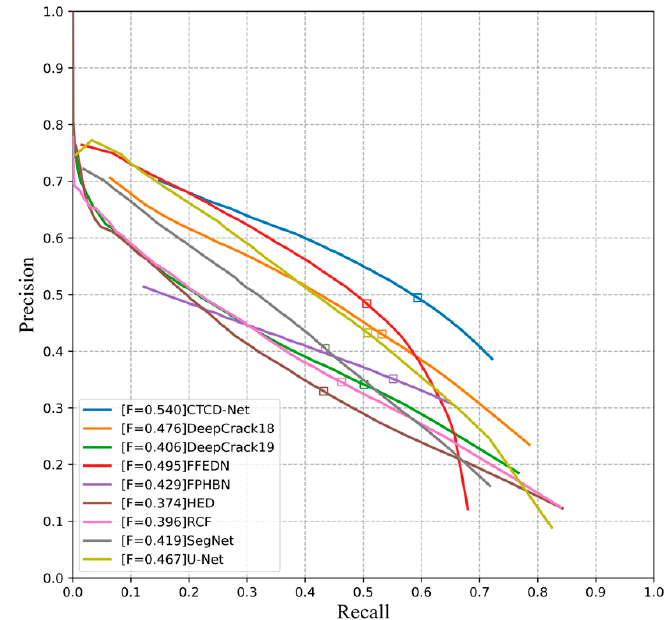
Figure 11. The PR curves of the generalization experiment. Table 4. Comparison results on generalization experiments.